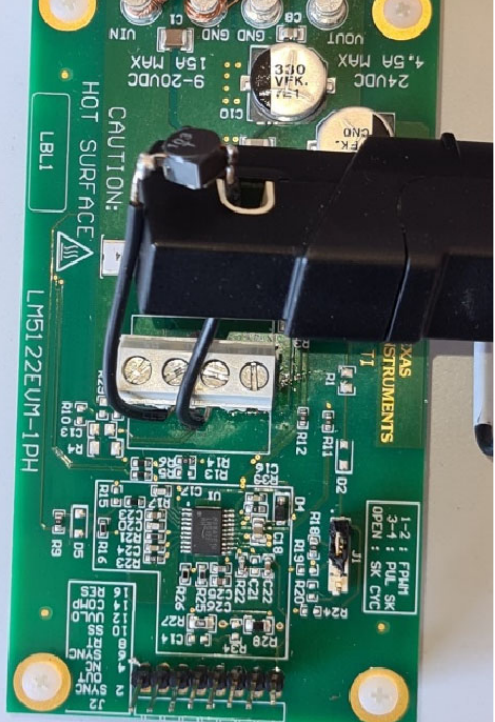
Figure 2. The EVM board modified to connect the non-linear inductor. A current probe is connected to sense the inductor current.